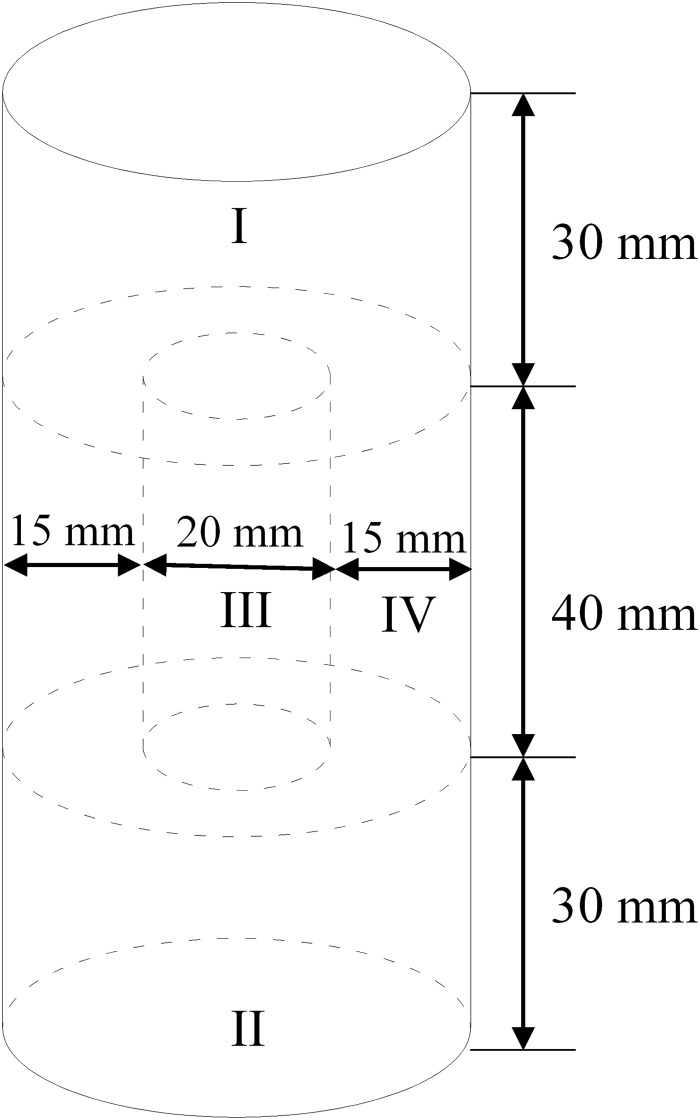
Size of the four areas in the analysis of CaCO3 content in the specimen.